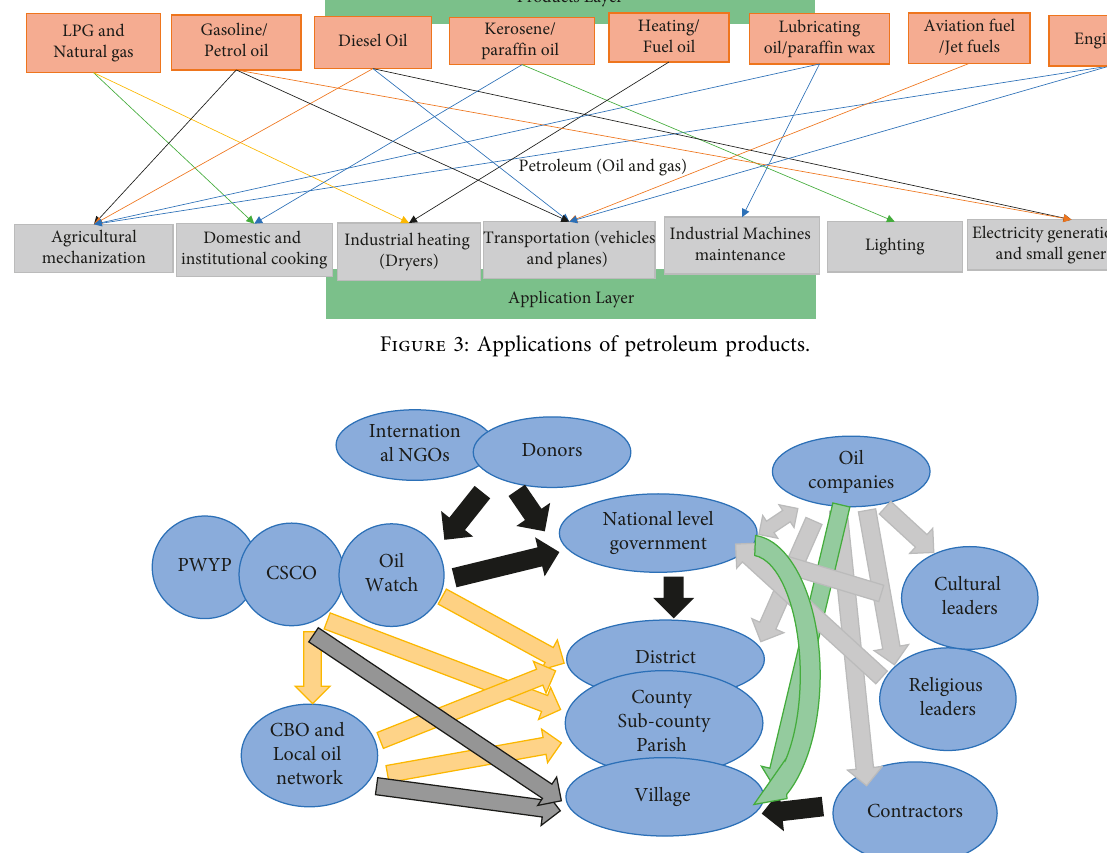
Figure 4: Space for governance in Uganda’s oil sector. CSOs: coherence among civil society organisations; CSCO: civil society coalition on oil and gas; PWYP: publish what you pay; CBOs: community-based organisations